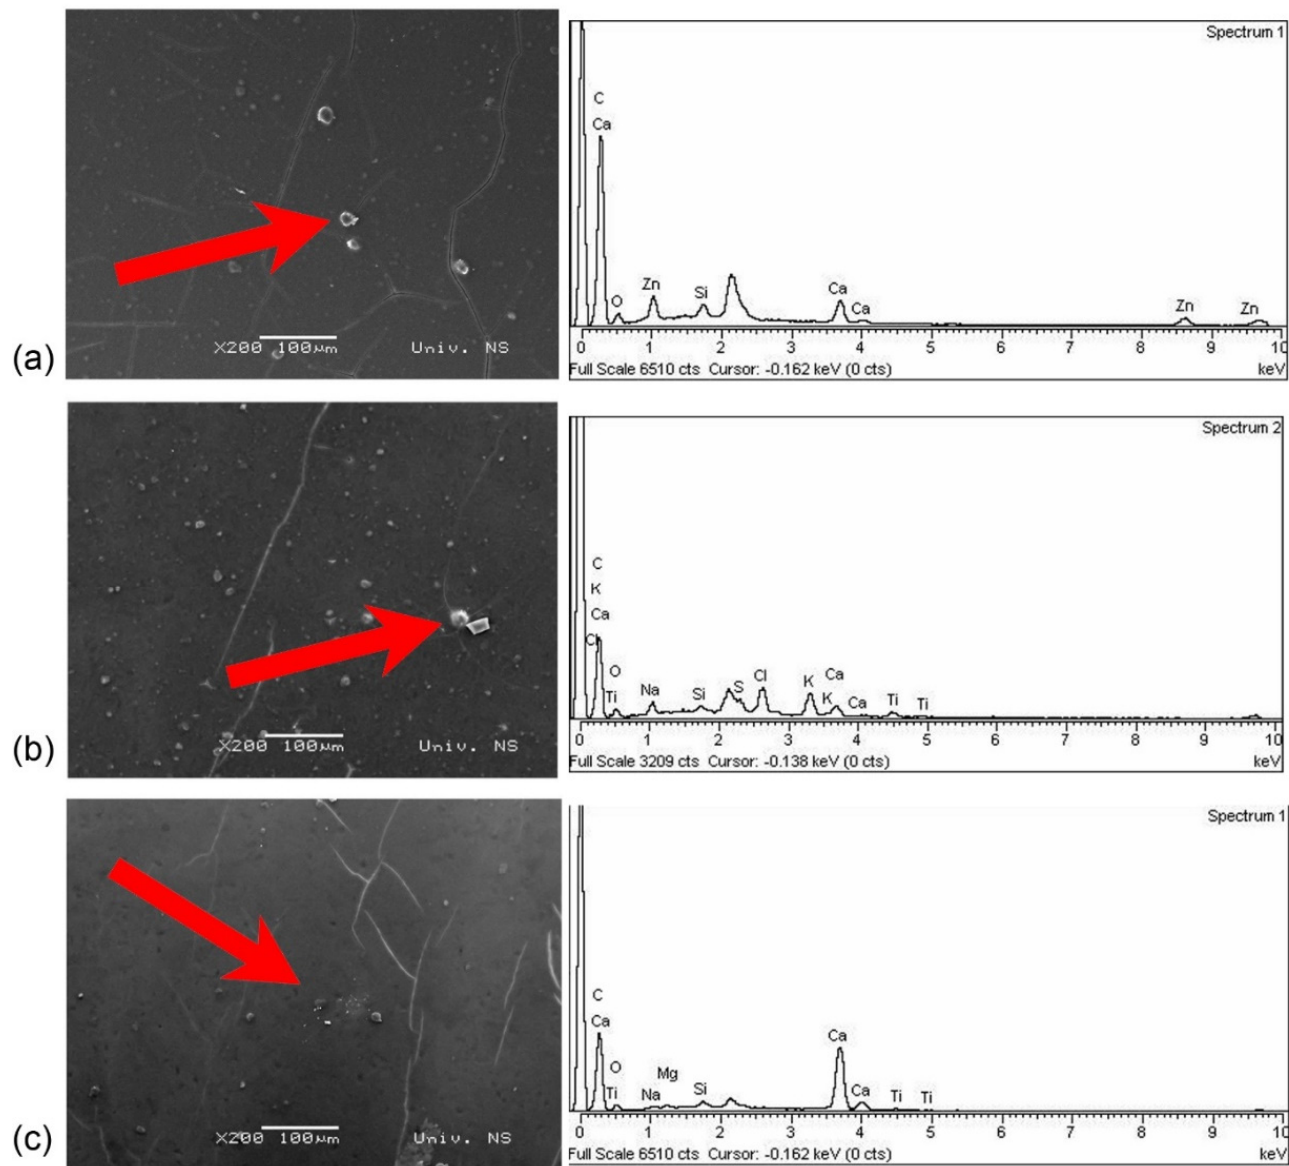
Figure 3. Position on the micrograph (red arrow) and EDS spectra on the samples: ( a ) 1% ZnO nanoclusters, ( b ) 1% TiO 2 nanoclusters, ( c ) 1% TiO 2 /SiO 2 nanoclusters.